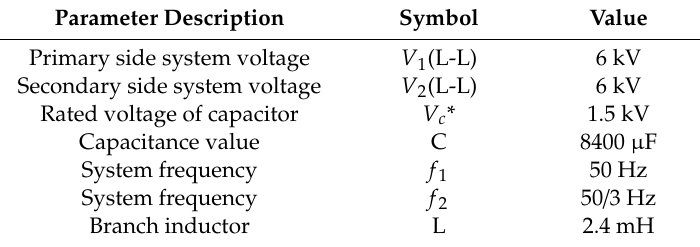
Table A1. Parameters of the circuit.